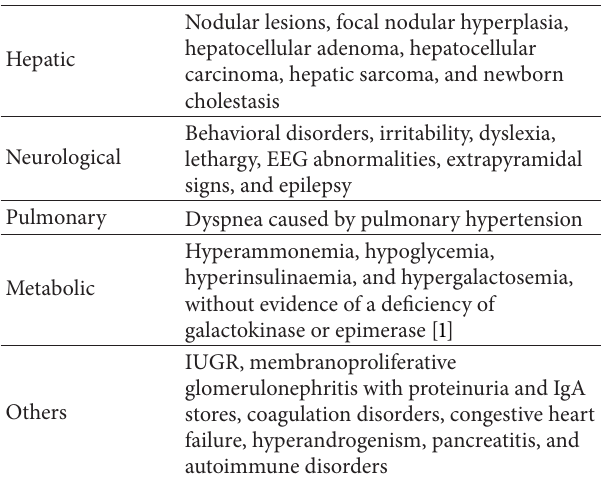
Table 1: Clinical manifestations associated with congenital por- tosystemic shunt